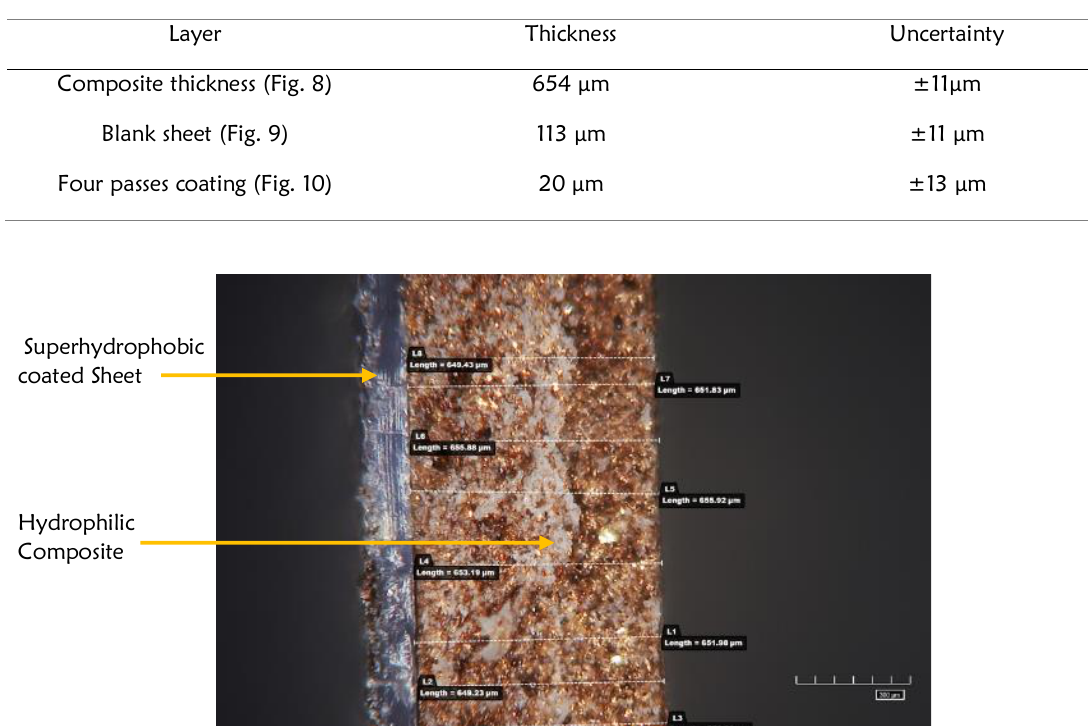
Table 2: The layers thicknesses for the sample designed with diameters of 500um and a pitch of 1500um as measured optically